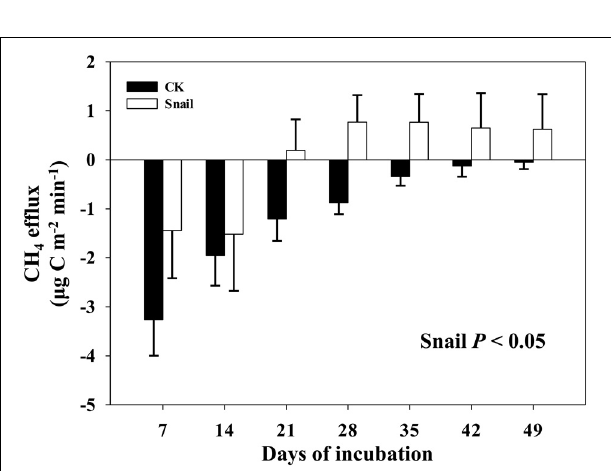
FIGURE 2 | The relationships of snail density with potential CH 4 production (A), and potential CH 4 oxidation (B) rates in the upper 5cm sediment of Poyang Lake. Vertical bars denote standard errors of means ( n = 3).